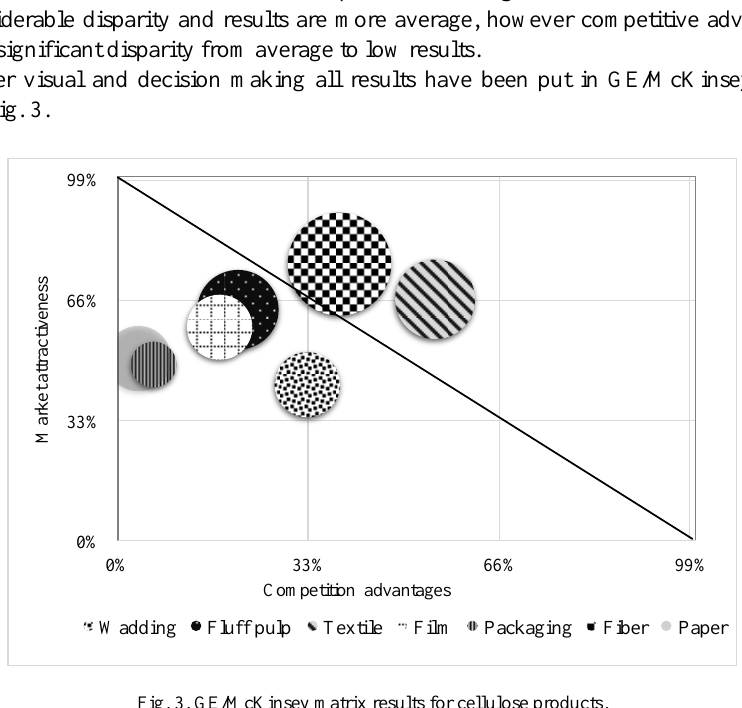
Fig. 3. GE/McKinsey matrix results for cellulose